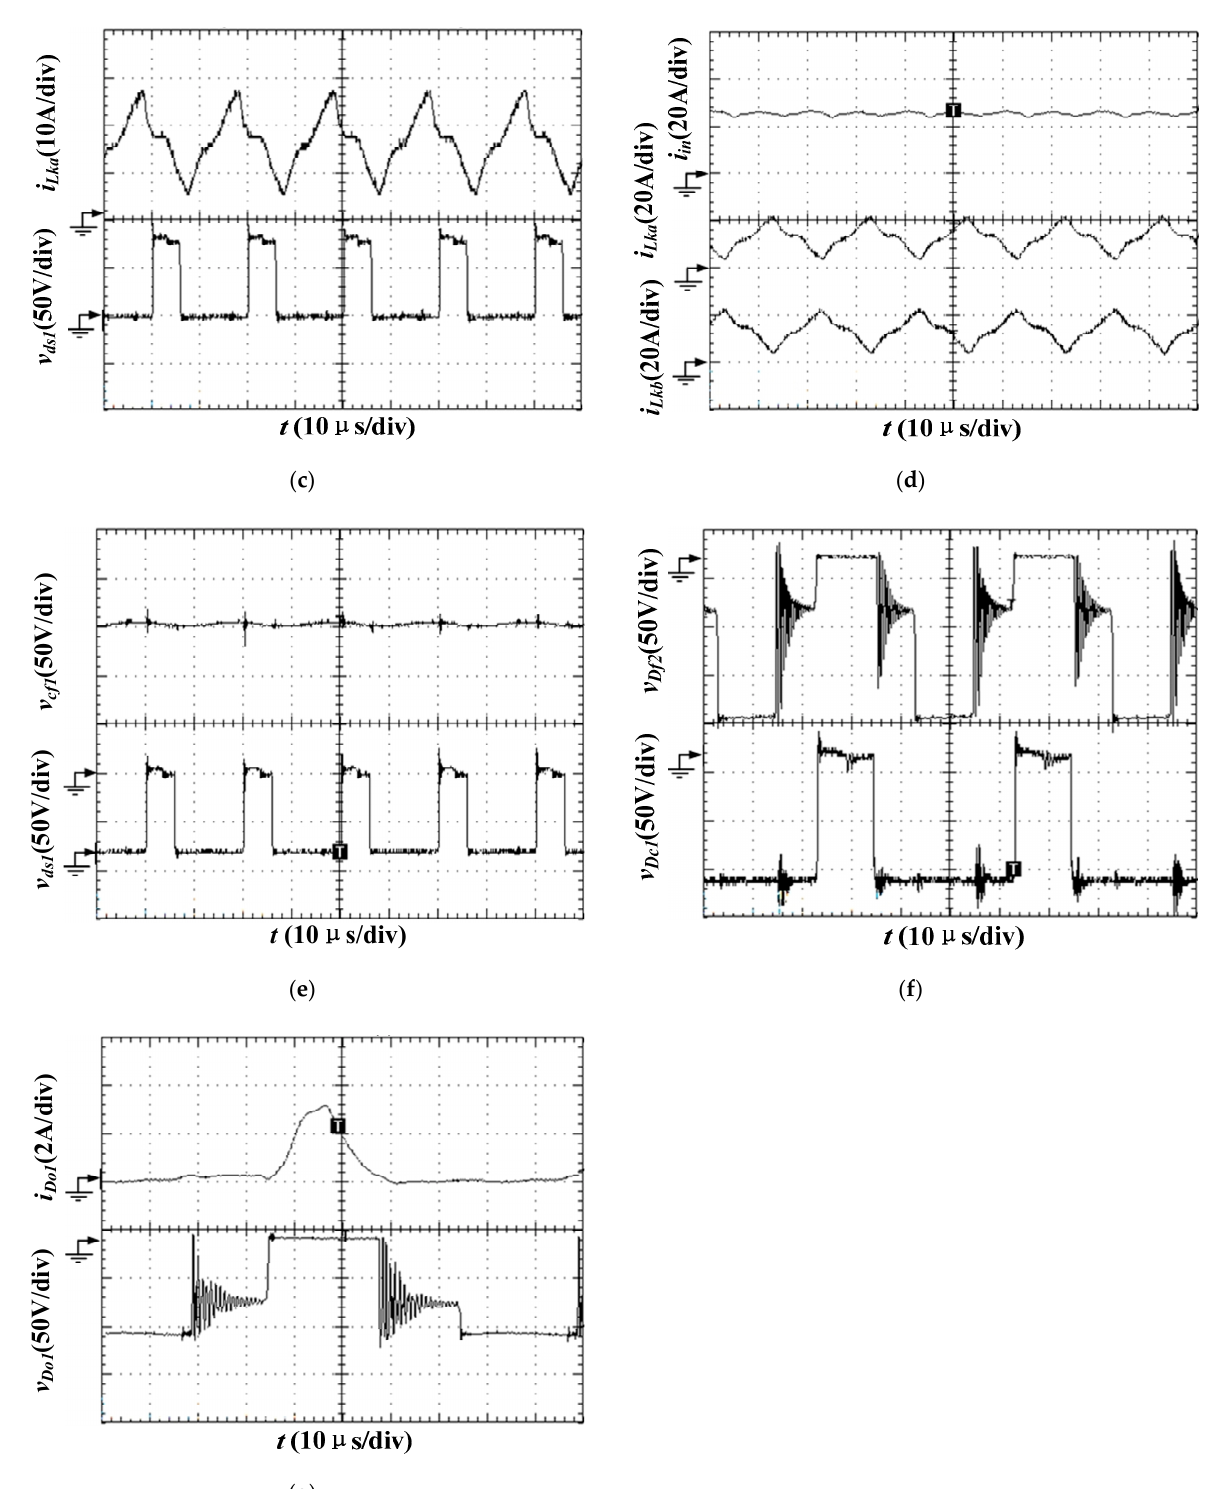
Figure 11. Experimental waveforms. ( a ) Voltage stress waveform and the driving signal waveform of S 1 . ( b ) Voltage waveform of S 1 and the voltage waveform of clamp capacitor C 1 . ( c ) Voltage waveform of S 1 and the current waveform of leakage inductance. ( d ) Input current waveform of the converter and current waveforms of two leakage inductances. ( e ) Voltage waveform of S 1 and voltage waveform of C f 1 . ( f ) Voltage waveforms of D c 1 and D f 2 . ( g ) Voltage and current waveforms of D o 1